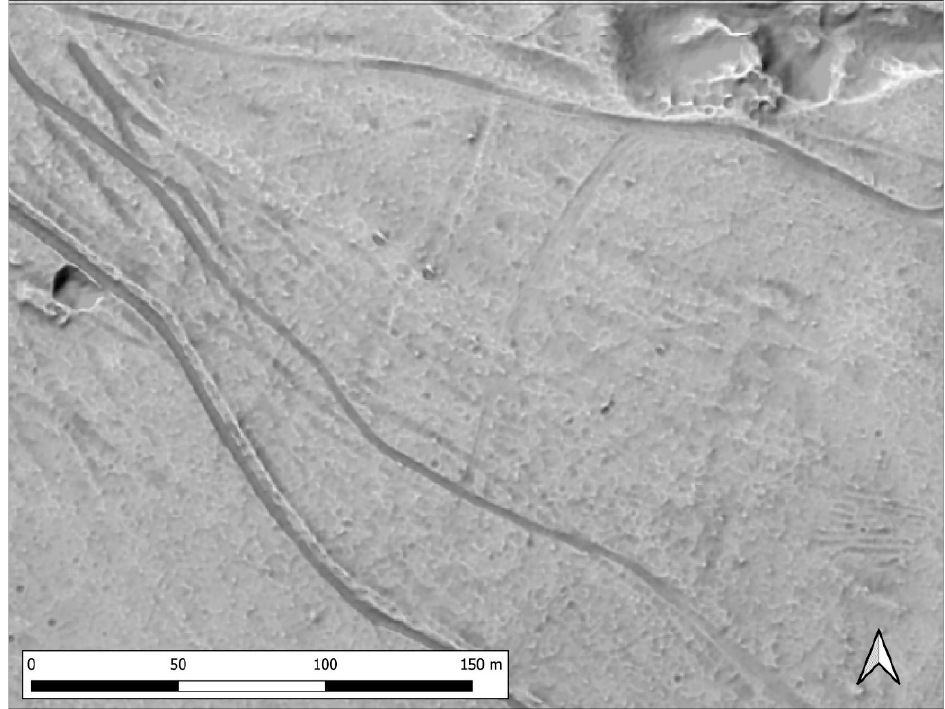
Figure 7. Positive openness visualisation of a part of the Area 3 showing part of a network of hollow ways cut into terrain by long-term repeated use in combination with rainwater runoff. Due to its complexity, it is almost impossible to consistently split this network into individual features when interpreting all datasets.